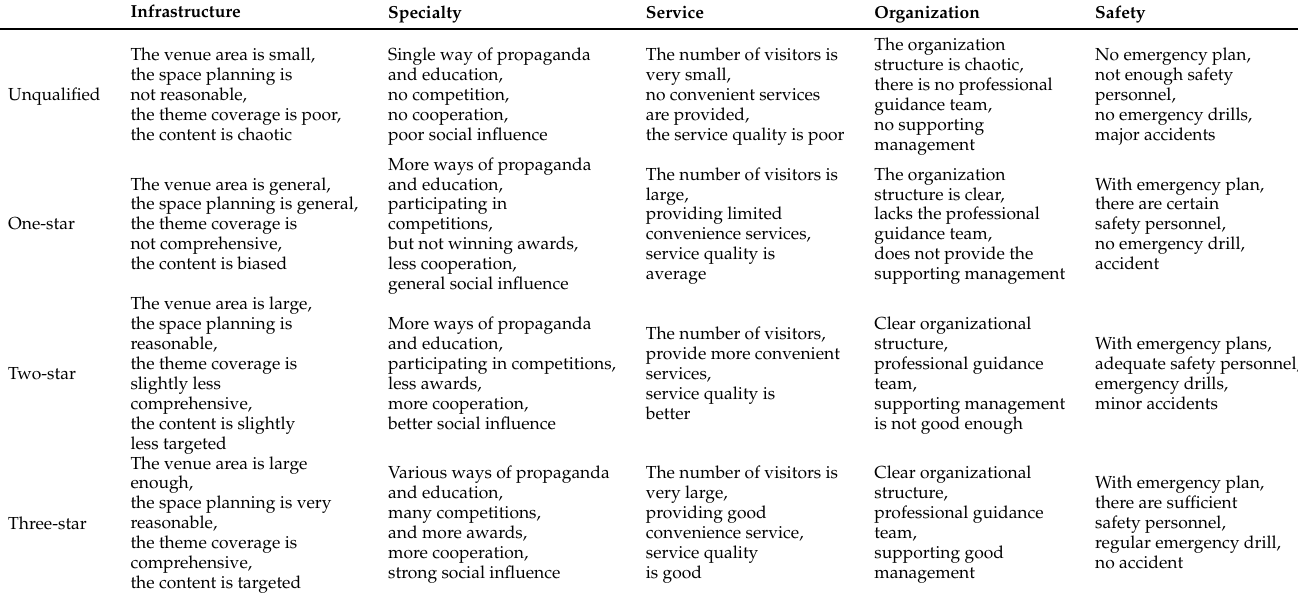
Table 2. Performance of different levels of public safety education venues in five